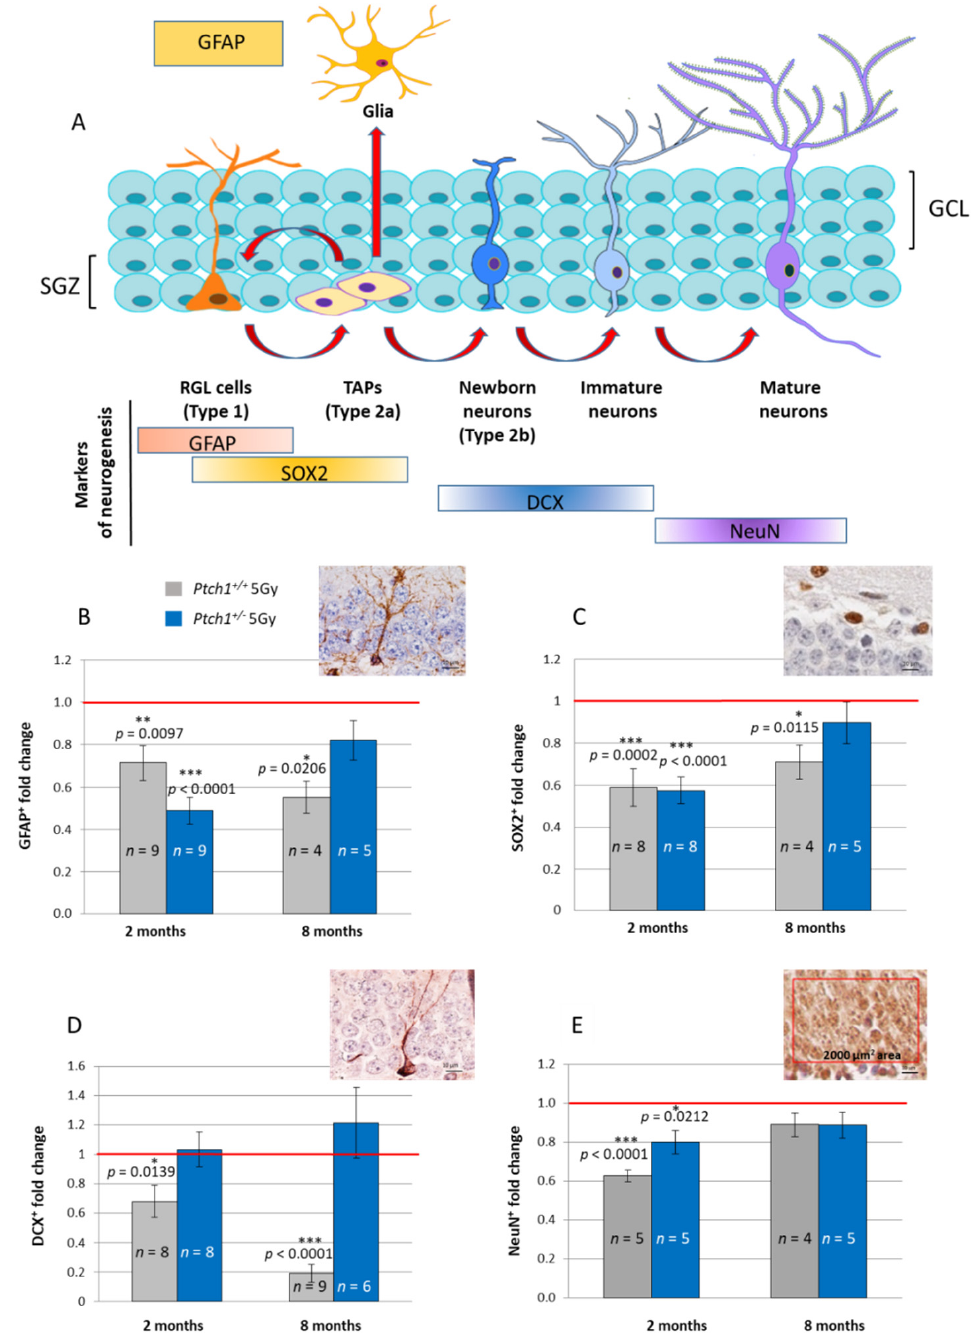
Figure 1. Effect of irradiation with 5 Gy of X-rays at P10 on the lineage-specific composition of DG in WT and Ptch1 +/ − mice at 2 or 8 months post-irradiation. ( A ) Schematic representation of adult neurogenesis in the hippocampal DG and relative stage-specific markers. Representative immunostaining images and quantification for ( B ) glial fibrillary acidic protein (GFAP), ( C ) sex determining region Y (SRY) box 2 (SOX2), ( D ) doublecortin (DCX) and ( E ) mature neurons (NeuN). The red rectangular field of 2000 µm 2 in E delineates a representative area in which NeuN analysis was carried out. Images, 100× magnification, scale bar = 10 µm. Immunohistochemical analysis for NeuN was carried out in a rectangular field of 2000 µm 2 in the supra- and infrapyramidal blade. The number of mice used per test is indicated with n in the graphs (n). Data are reported as mean ± SEM * p < 0.05; ** p < 0.01; *** p < 0.001 for comparison with controls (Student t -test).